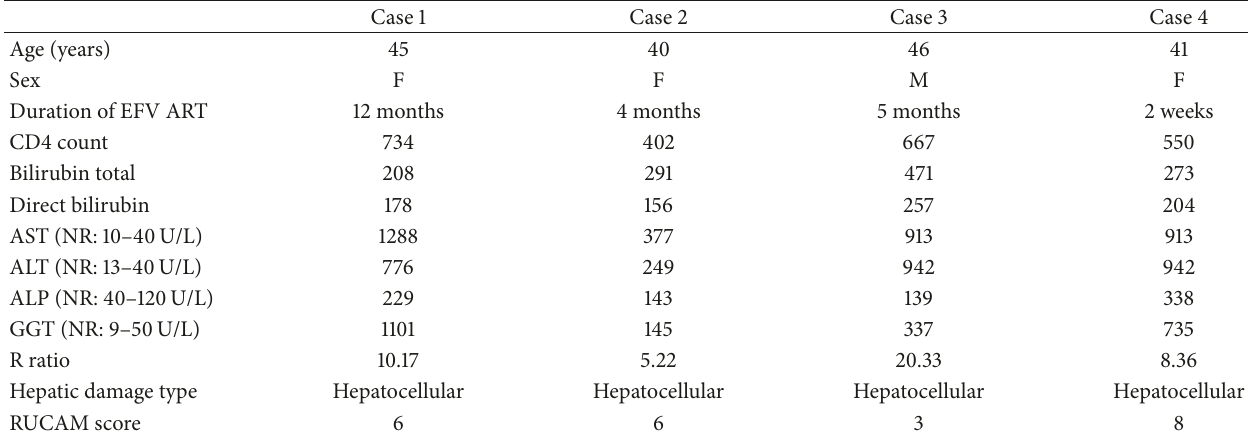
Table 1: Patient characteristics and laboratory test